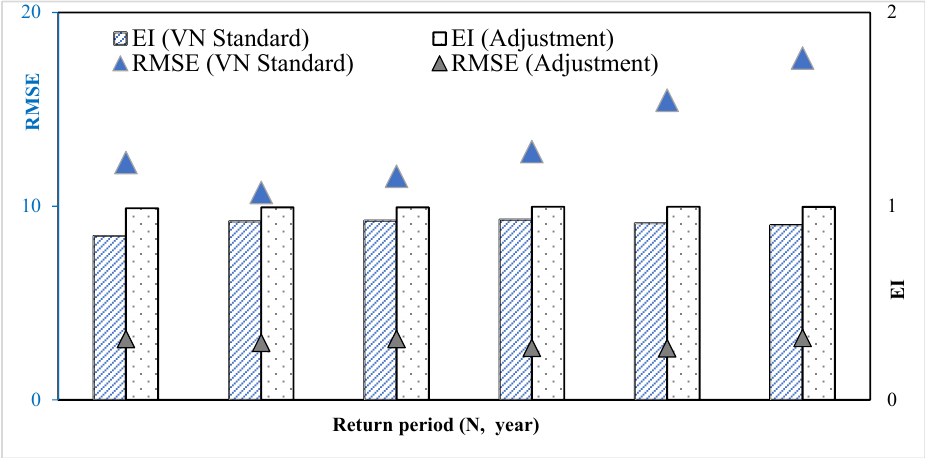
Figure 11. Comparing IE and RMSE according to the TCVN and adjustment dataset.